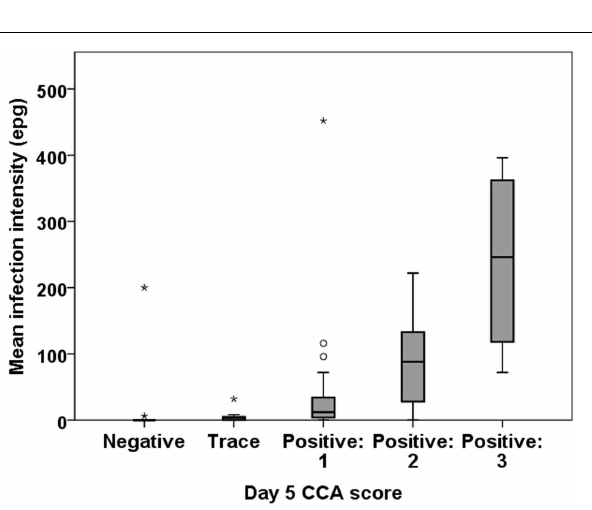
FIGURE 3 | Correlation between intensity of infection by Kato-Katz (EPG) and band intensity by POC-CCA . Representative boxplot is shown from day 5 POC-CCA test.There is a significant association between the EPG and CCA band intensity: Spearman’s rho = 0.601 ( P <